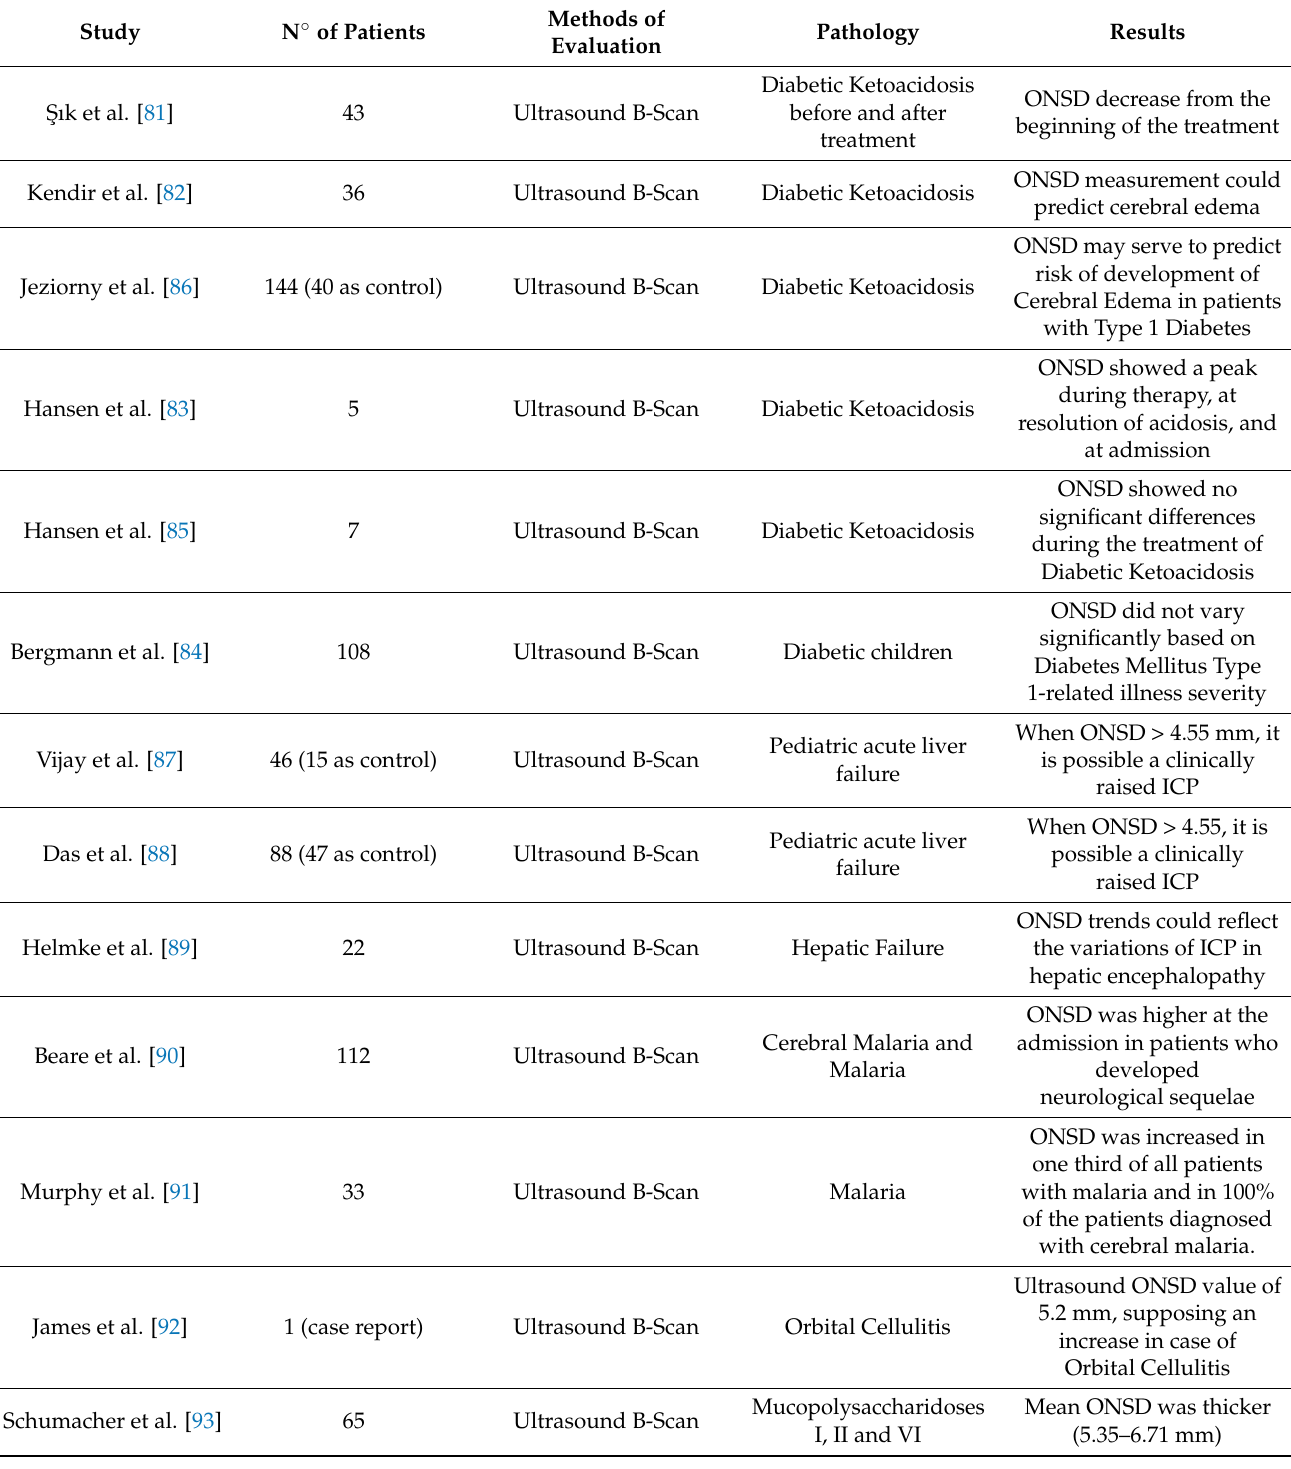
Table 2. Main findings of the papers related to optic nerve sheath diameter ultrasound evaluation in children with systemic and ocular